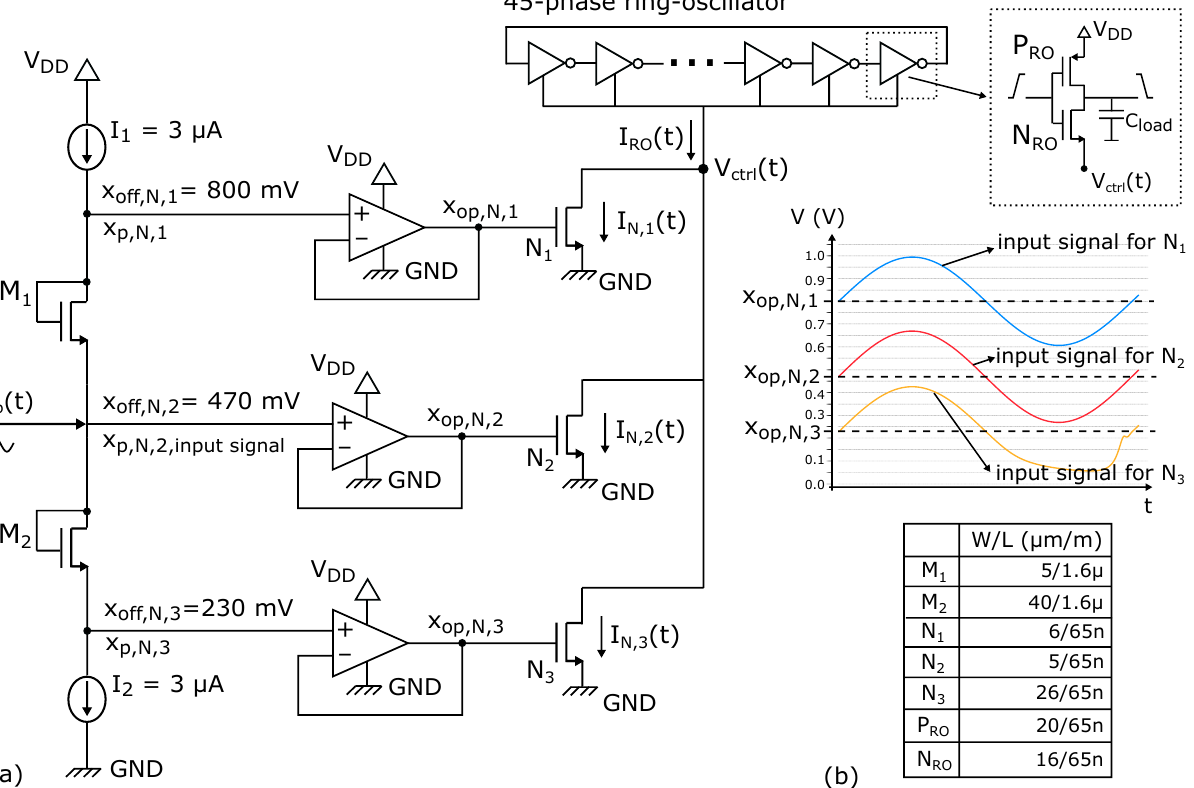
Figure 6. Trimming circuit used to generate the offset references of the ring-oscillator, ( a ) schematic and ( b ) device sizes and